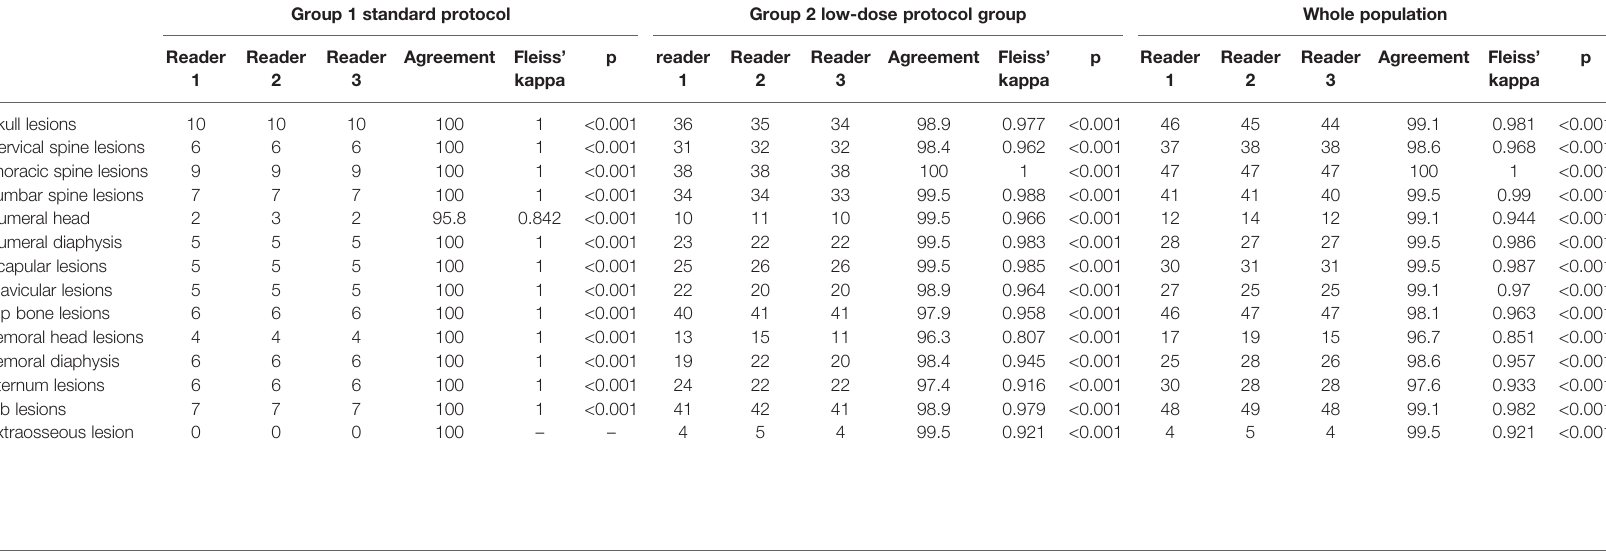
TABLE 3 | Osteolytic lesions detection inter-rater reliability.